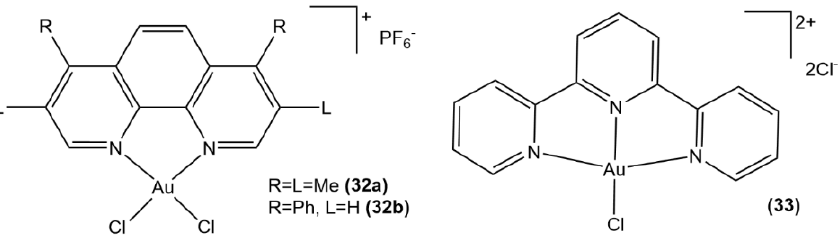
Figure 16. Au(III) complexes with substituted phenanthroline ( 32a , 32b ) and terpyridine ( 33